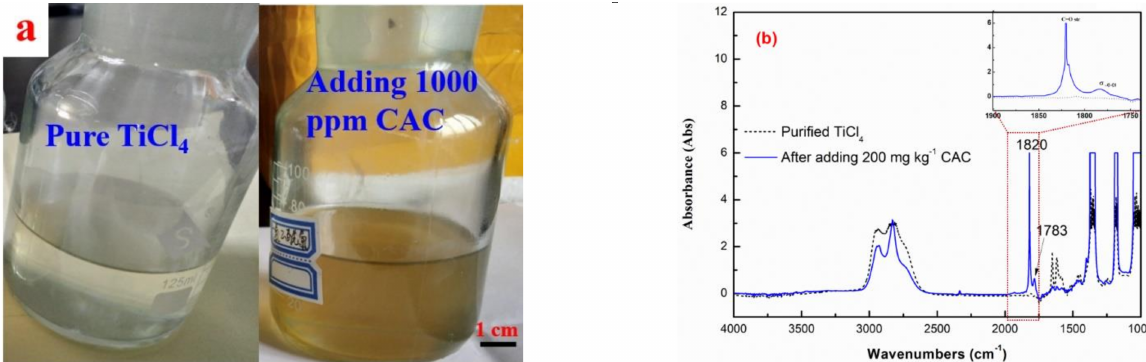
Figure 4. ( a ) Digital photographs and ( b ) FTIR spectra of TiCl 4 before and after CAC addition.